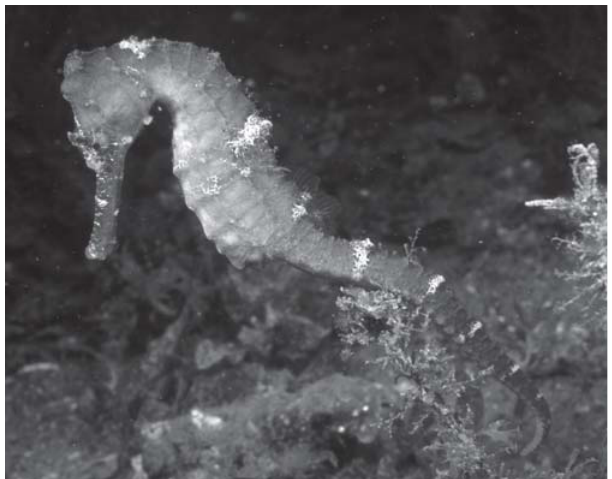
Fig. 2. Hippocampus reidi . Photo (inverted): Ary